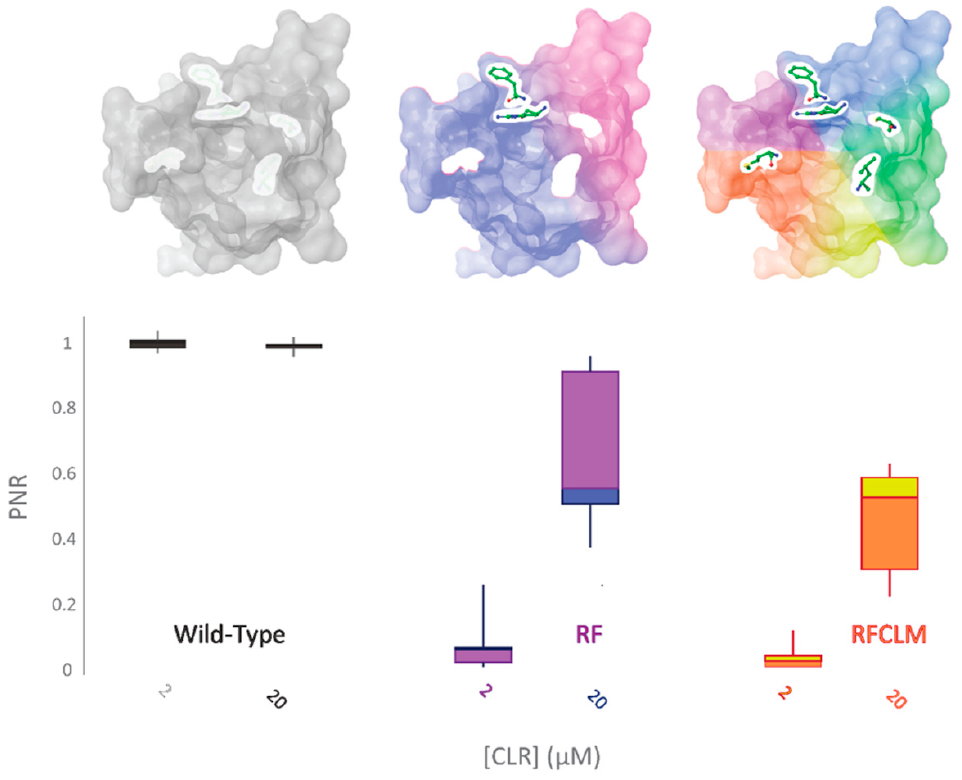
Figure 5. RF-PxRyR and RFCLM-PxRyR share a similar phenotypic response to CLR exposure. Sf9 cells (n = 10) expressing either Wild-Type (grey), RF (blue/purple) or RFCLM (yellow/orange) PxRyR were exposed to 2 µM and 20 µM concentrations of CLR. All diamide responses are expressed as proportional normalised responses (PNRs). Error bars represent SEM.